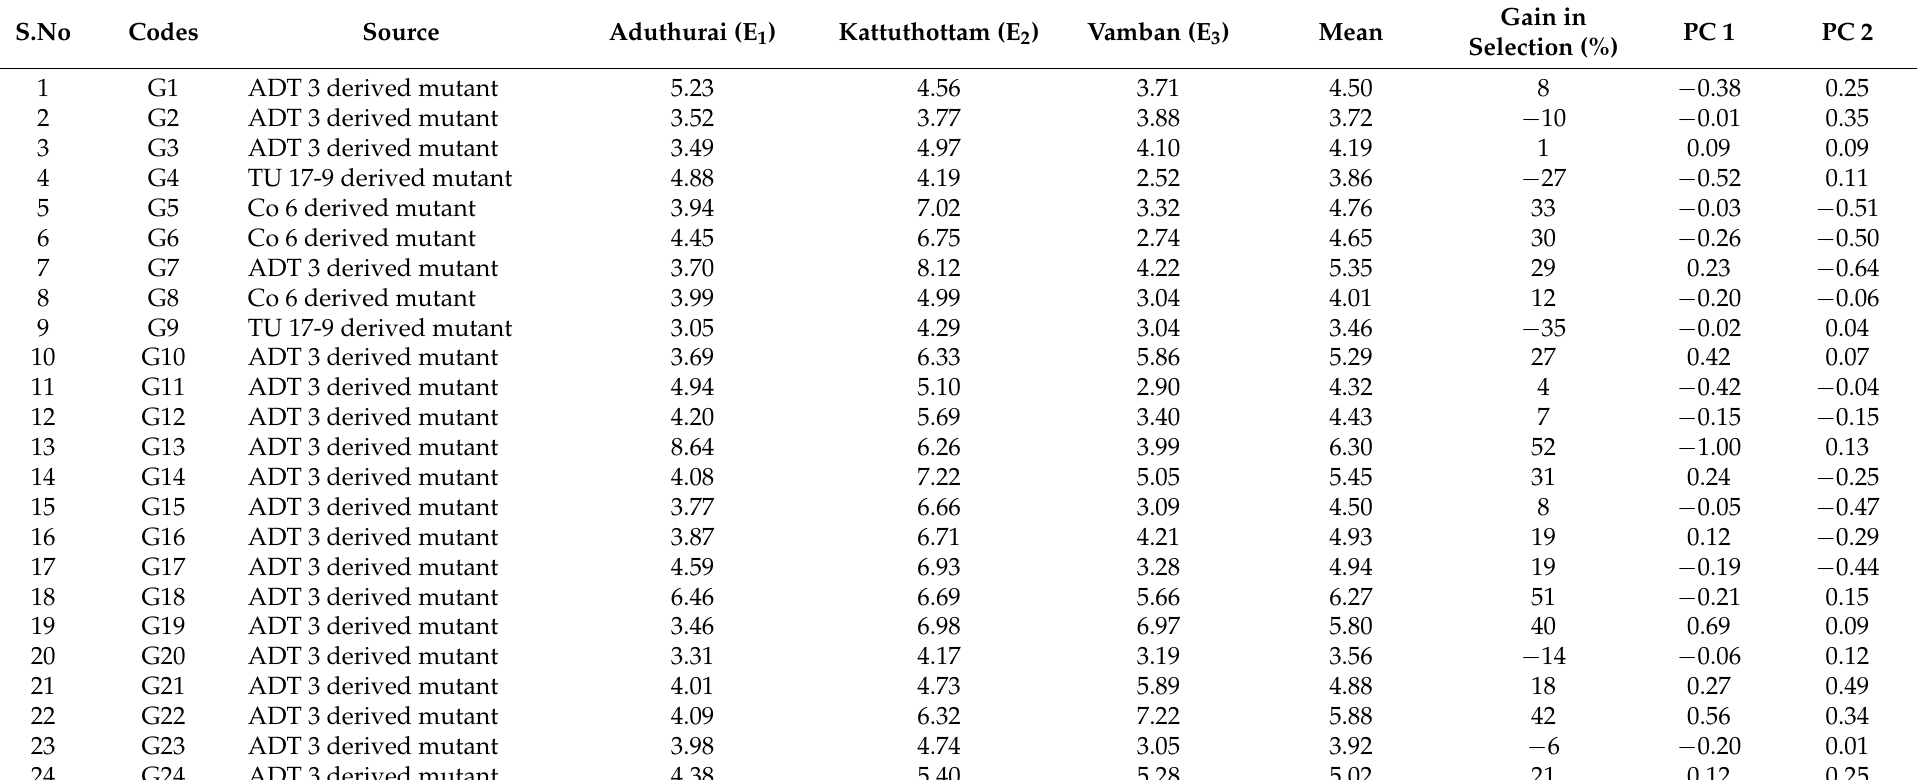
Table 5. Mean single plant yield, principal component analysis of blackgram mutant accessions, parental genotypes, and gain in selection (%) over respective parent/check.